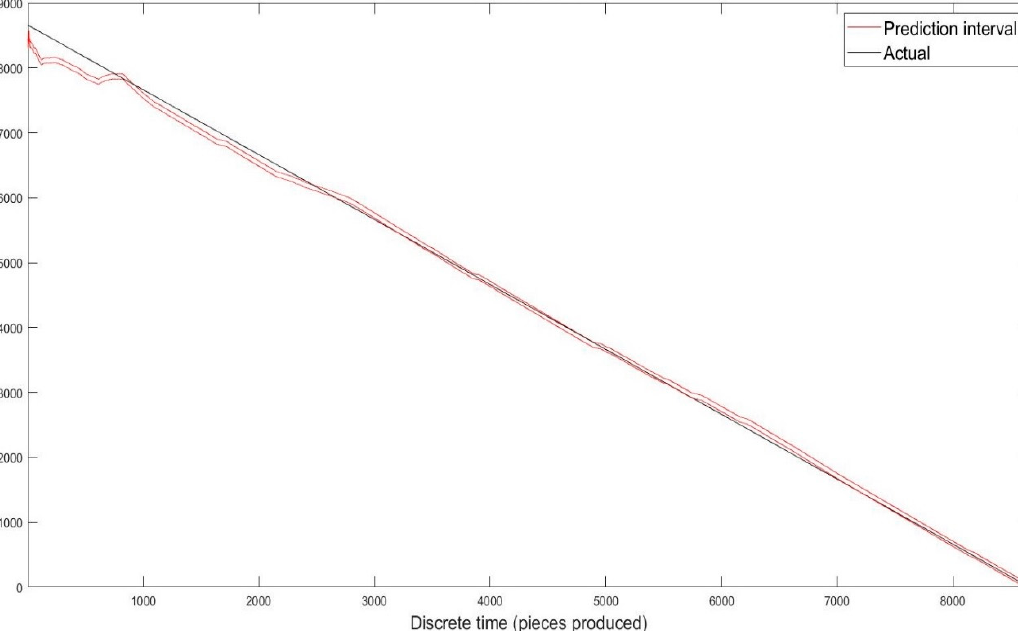
Figure 8. A sample of prediction simulation outcome.